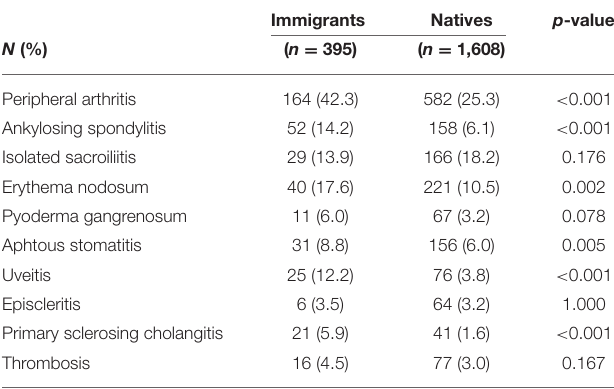
TABLE 2 | Extraintestinal manifestations in the immigrant and native-born IBD population in Spain. Immigrants Natives p -value